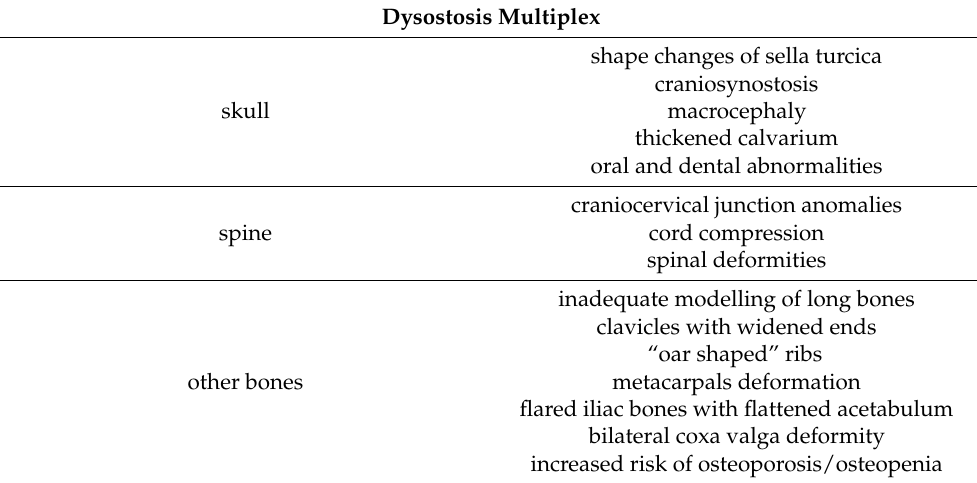
Table 2. Typical imaging findings of bony dysplasia in